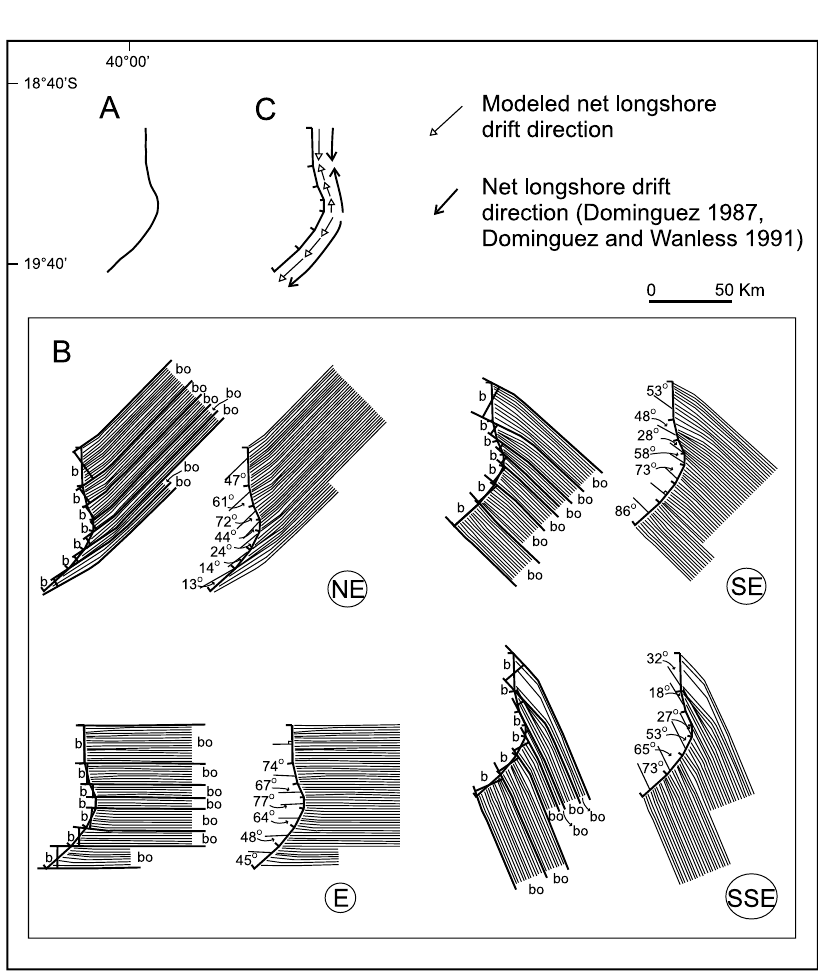
Fig. 4 – (A) Coastline in the Doce River around 5600 cal yr BP (see Fig. 3). (B) Refraction diagrams for waves with a 5-s period, coming from NE and E, and 6,5-s period, coming from SE andSSE.Herearealsoshown: 1)differentsegmentsintowhichtheshorelinewasrectilinearized, 2) incidence angles formed by the wave-rays in relation to the coastal segments and 3) mea- surements of b and b o (see text) used to estimate wave height along the shore segments. (C) Rectilinearized shoreline showing the directions of net longshore drift of sediments estimated from numerical modeling and from Dominguez (1987) and Dominguez and Wanless